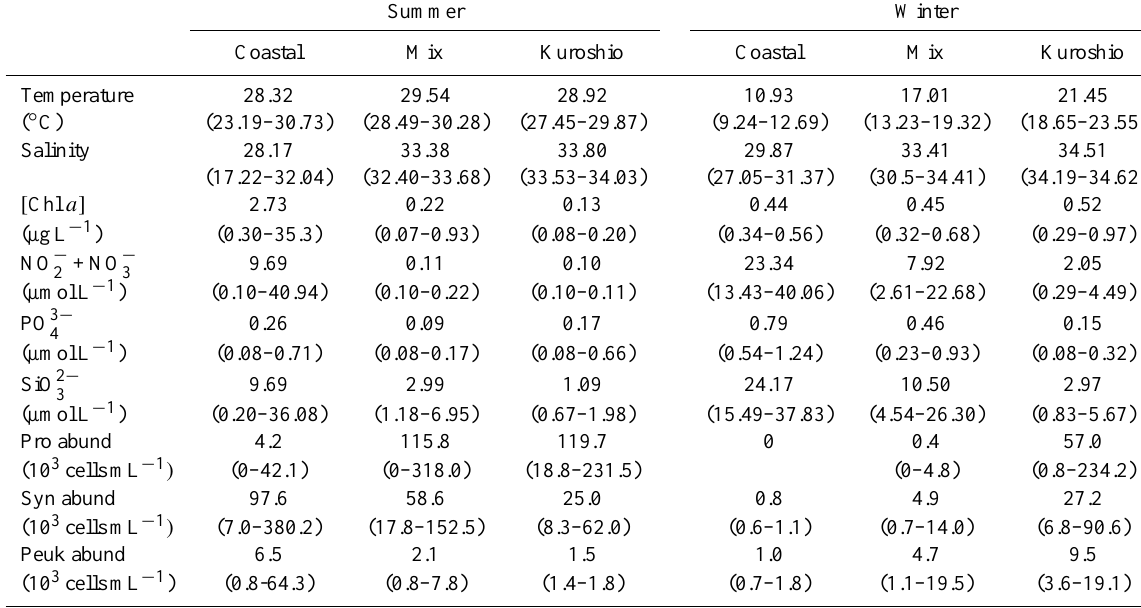
Table 1. Summary of environmental factors and biomass of picophytoplankton populations in the three water systems in the ECS. The values reported here are averages of surface data, with the range of the values in parentheses.